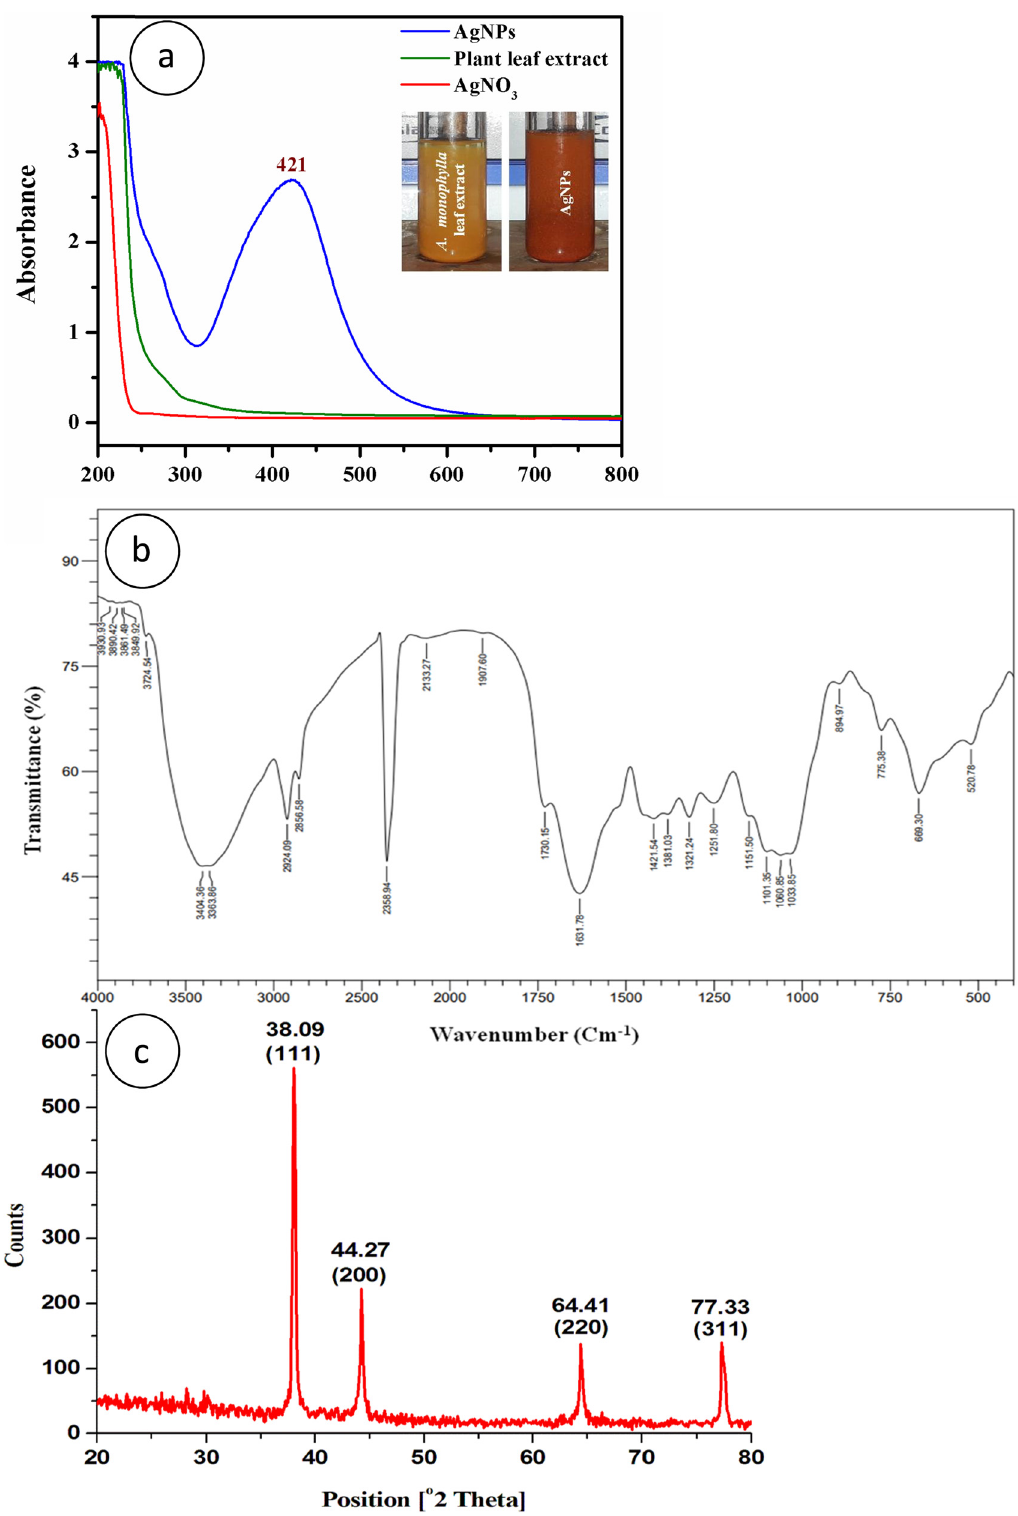
Figure 3: ( a ) UV - Vis, ( b ) FTIR, and ( c ) XRD analysis of AgNPs synthesized using A. monophylla